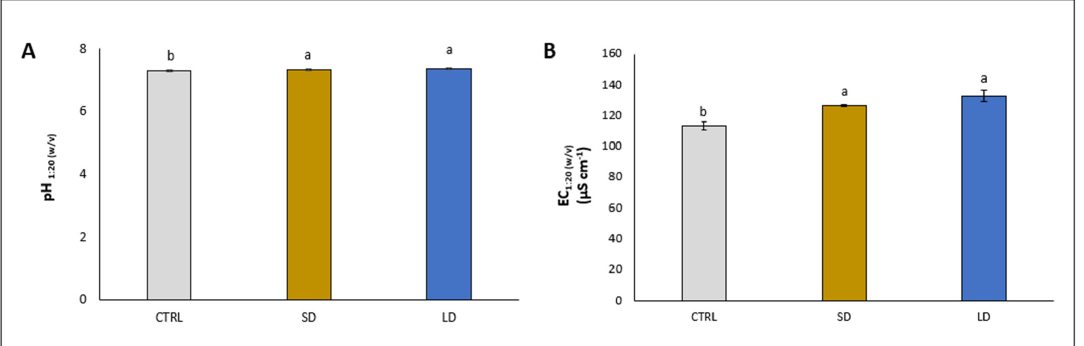
Figure 1. pH ( A ) and electrical conductivity (EC) ( B ) in soils where lettuce plants were grown for 5 weeks without (CTRL) and with the application of digestate, either solid (SD) or liquid (LD). Parameters are expressed as mean ± standard error. Different letters indicate statistically significant differences ( p < 0.05). Among the biometric and photosynthetic parameters analyzed in the lettuce leaves, a similar trend was observed with the addition of SD and LD. Specifically, the SD significantly decreased the leaf fresh weight ( − 39.5%), chlorophyll content ( − 16.5%), PI ABS ( − 25.1%), and fractal dimension ( − 2.3%), compared to their corresponding controls (Figure 2A, B, C, and D, respectively). On the contrary, LD significantly increased the leaf fresh weight (+22.9%), chlorophyll content (+6.2%), PI ABS (+11.0%), and fractal dimension (+2.3%), compared to their corresponding controls (Figure 2A, B, C, and D, respectively).